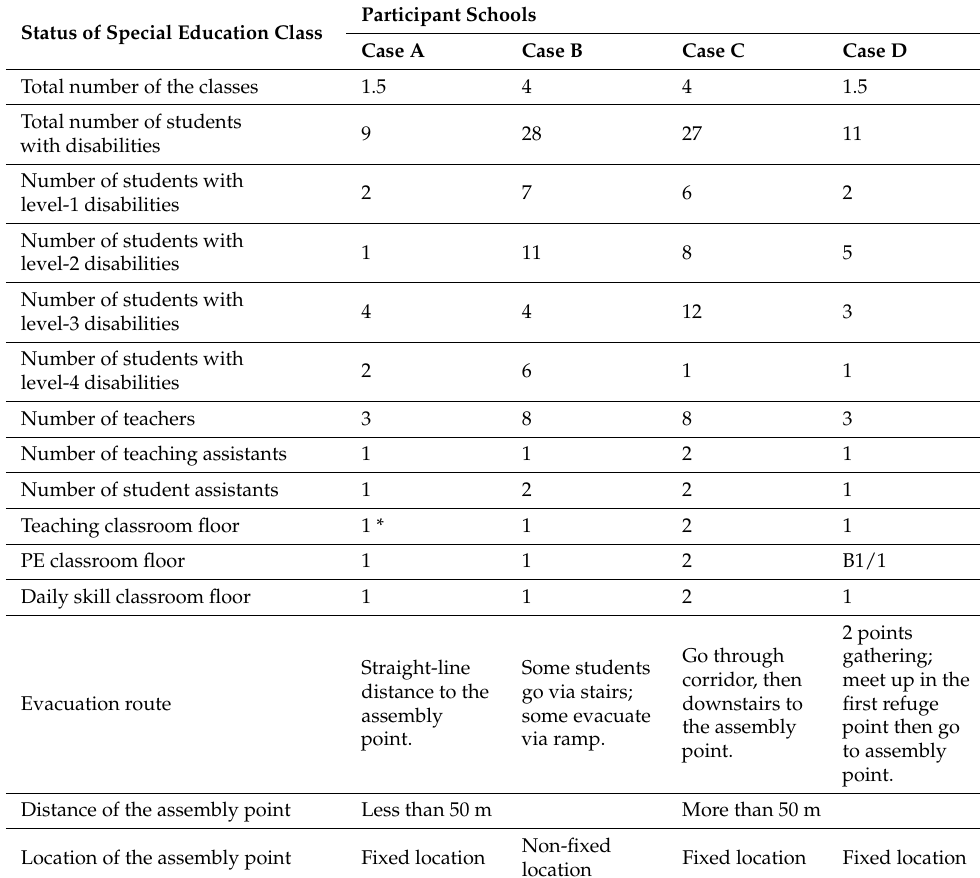
Table 2. Participant